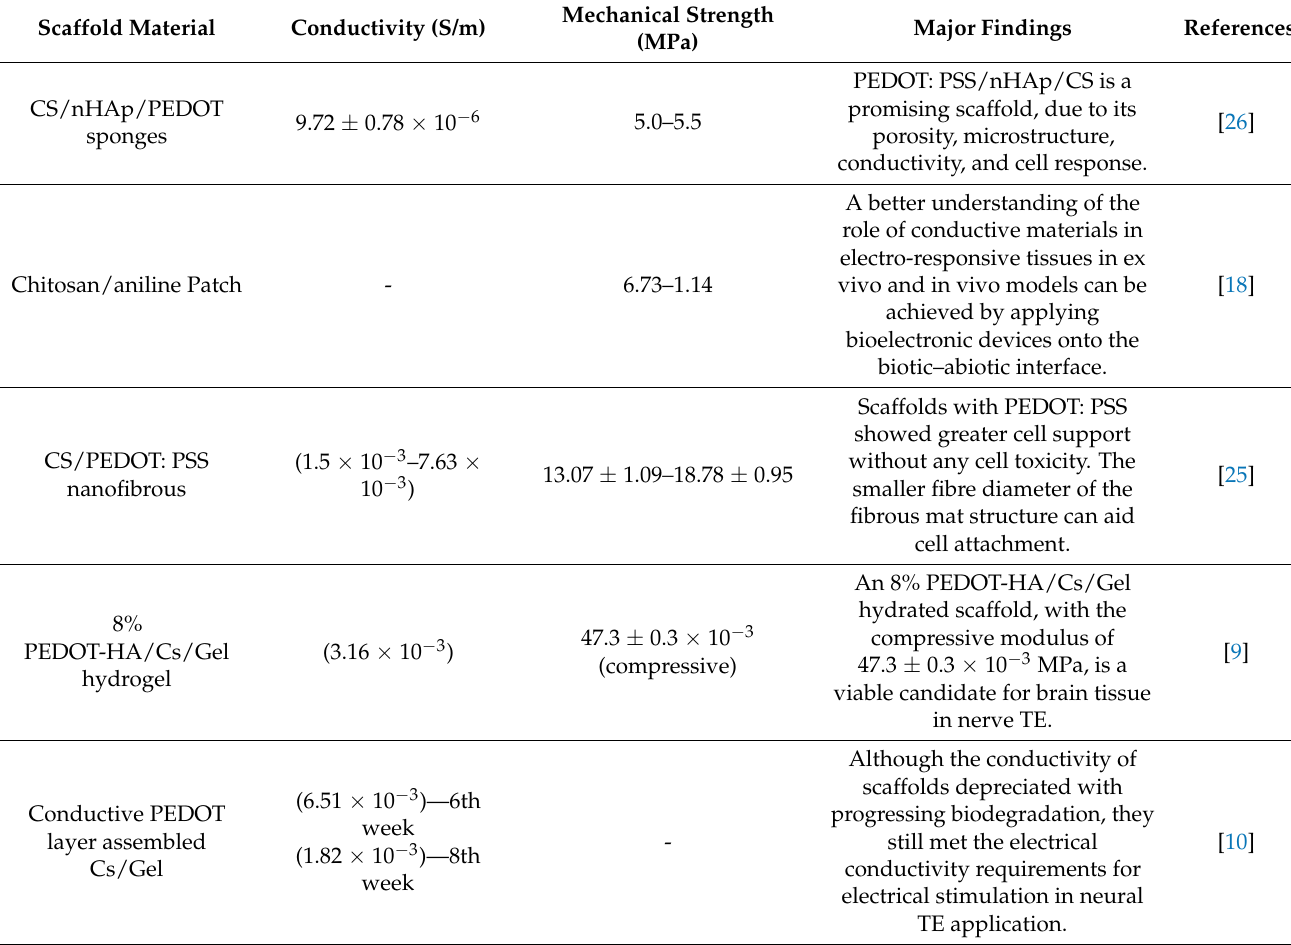
Table 2. Mechanical and electrical properties of conductive-based scaffold